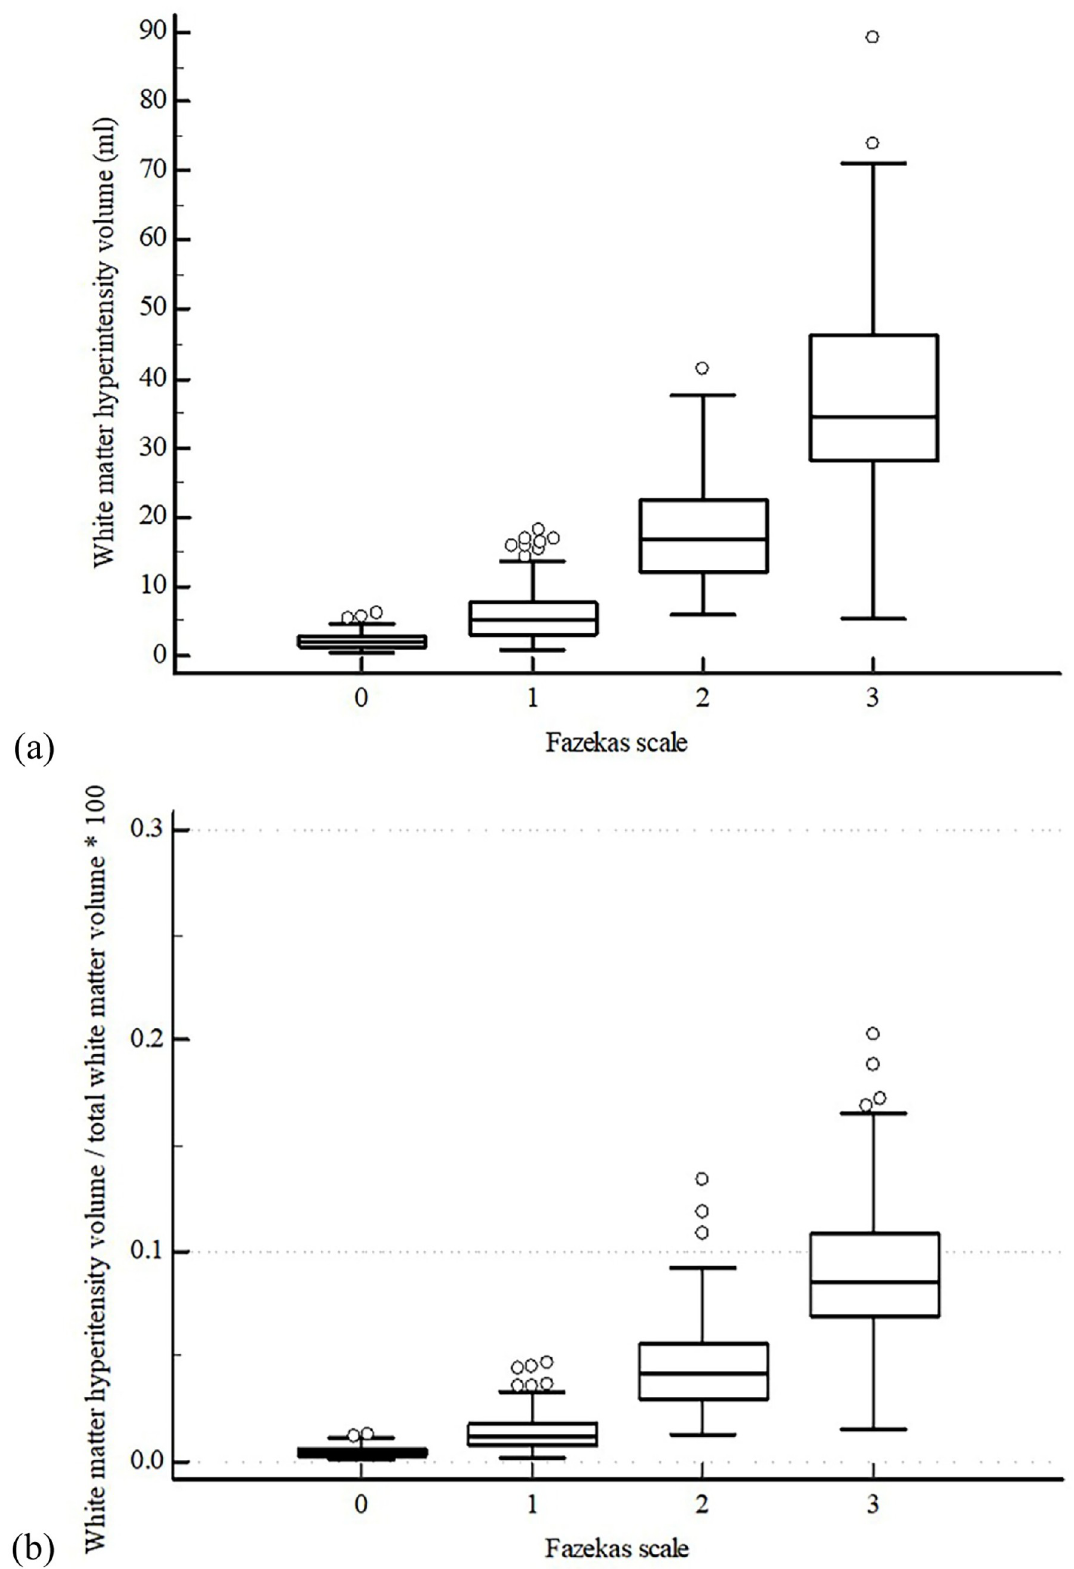
Fig 4. WMH volume (a) and WMH volume ratio (b) for Fazekas categories. https://doi.org/10.1371/journal.pone.0274562.g004 PLOS ONE | https://doi.org/10.1371/journal.pone.0274562 September 15,